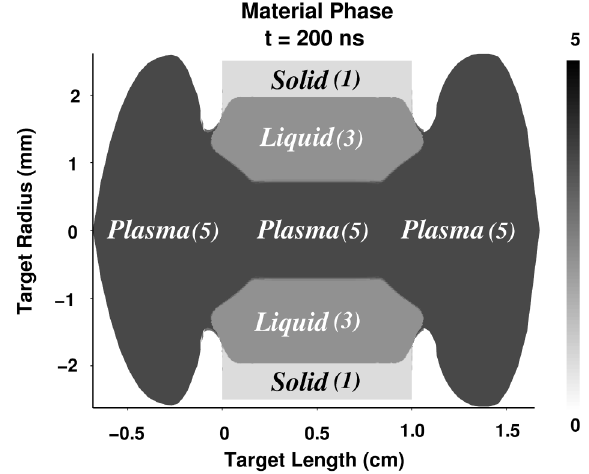
FIG. 15. Matter state at t (cid:3) 200 ns corresponding to the case shown in Fig. 5.